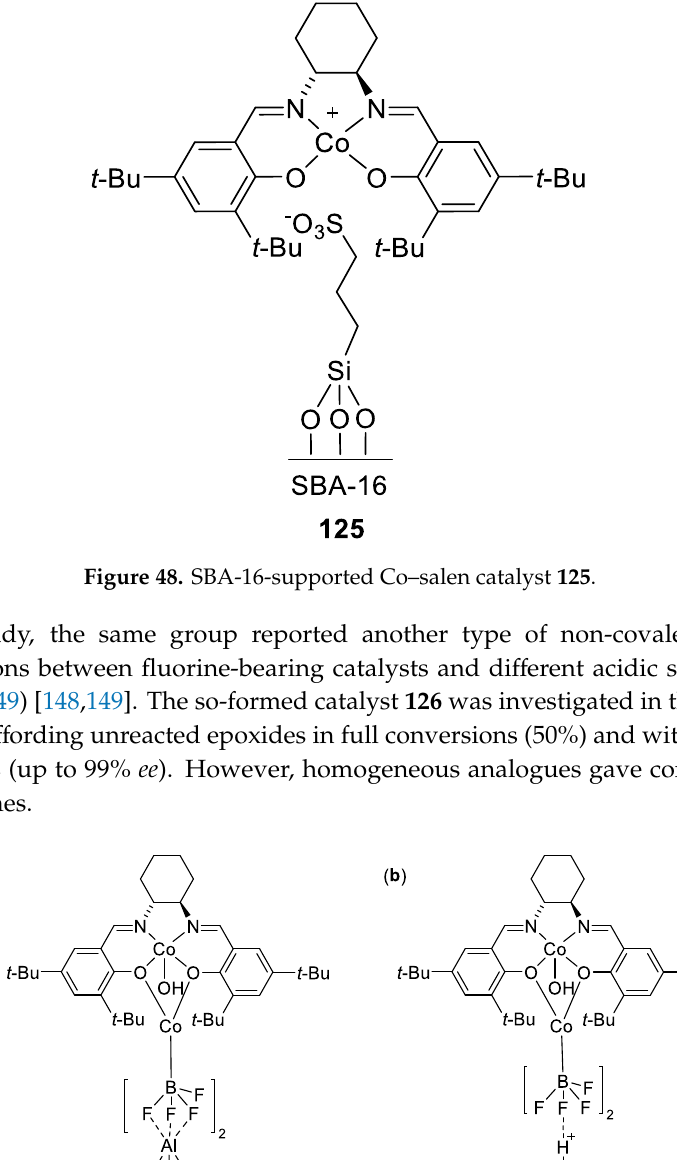
Figure 47. MCM-41-supported salen catalysts 118 – 124 .